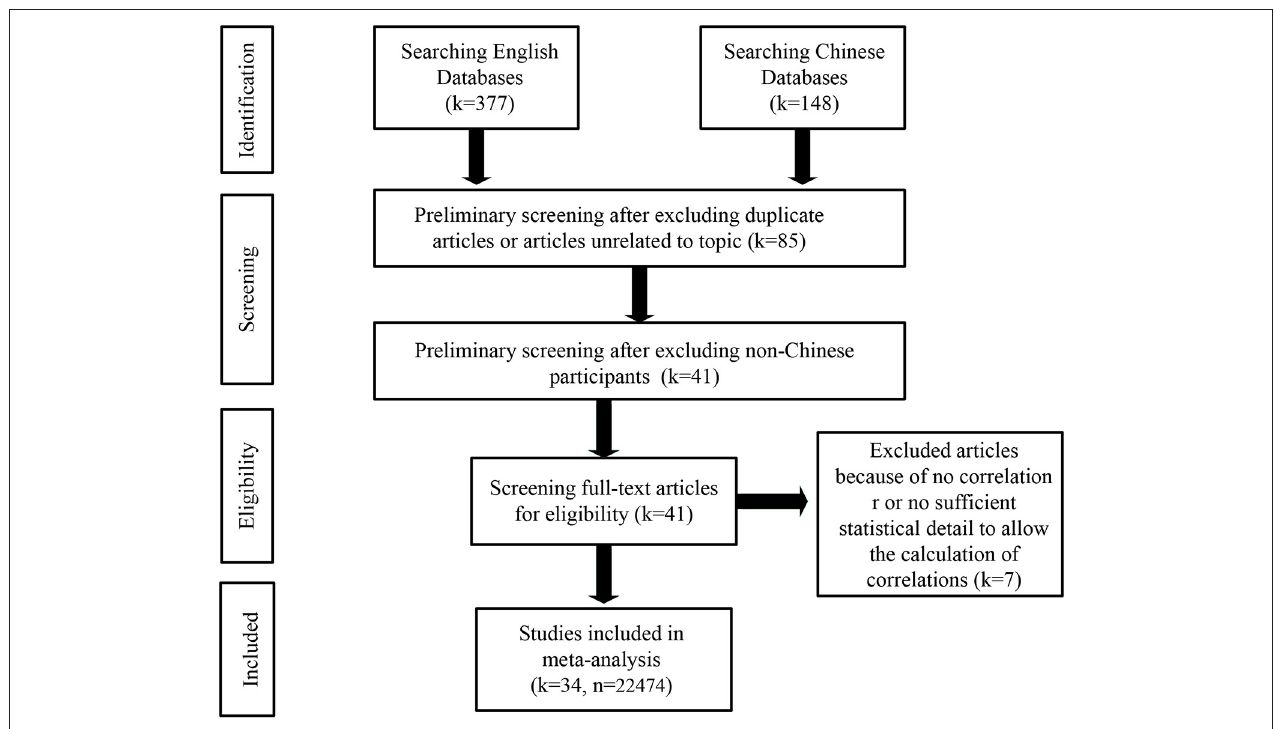
FIGURE 1 | The flow chart of the selection process. k , number of articles; n , total sample